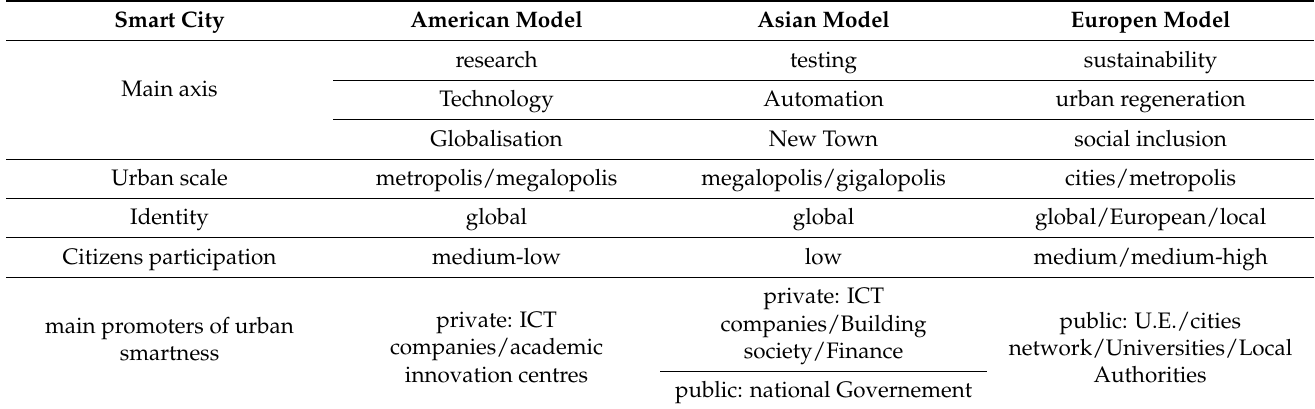
Table 2. The definition of the smart cities concept in different parts of the world